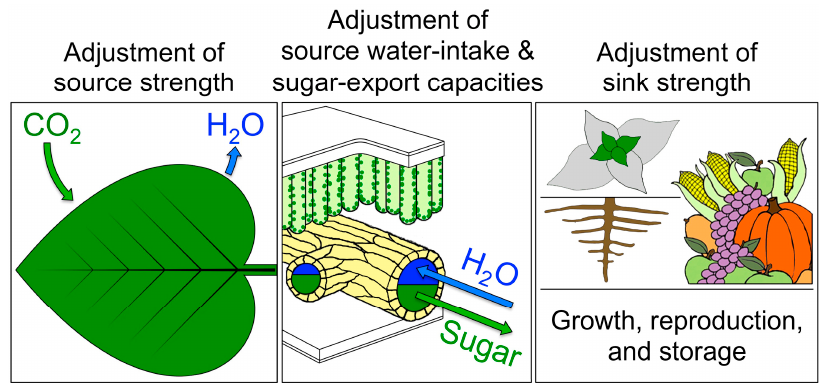
Figure 1. Schematic depiction of the three proposed adjustments necessary for plant productivity in a given environment: (i) photosynthetic capacity (light- and CO 2 -saturated intrinsic capacity of photosynthesis determined by the level of photosynthetic proteins) to provide sugars (the plant’s source strength) fueling crop yield; (ii) high flux capacities for distributing water throughout the leaf